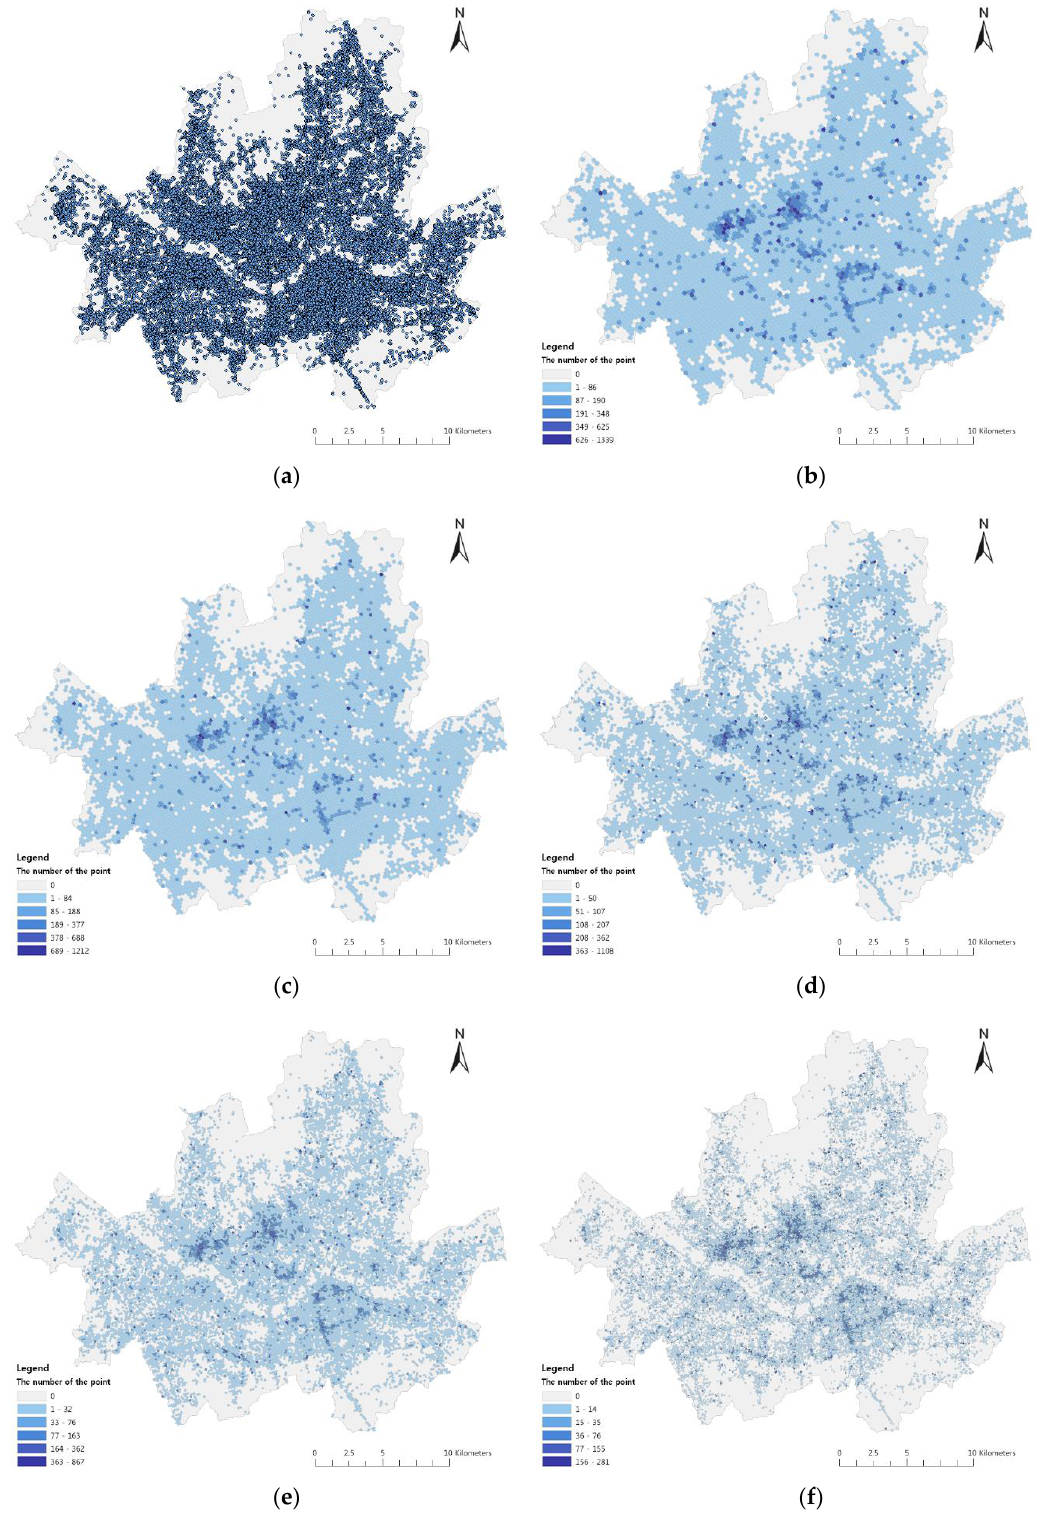
Figure 9. Result of clustering using the appropriate sizes of clusters: Distribution of ( a ) geotagged Twitter data; ( b ) level 9; ( c ) level 10; ( d ) level 11; ( e ) level 12; and ( f ) level 13.